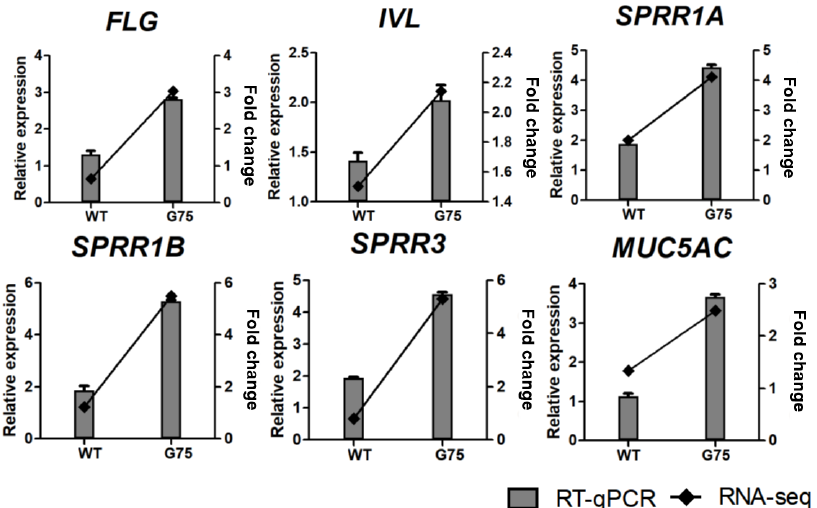
Figure 7. Real-time quantitative PCR validation of RNA-seq data for genes involved in epithelium development and differentiation from HT-29 stimulated by CotG-p75. The right and left y-axis represent the fold change of RNA-seq data and relative expression of RT-qPCR data, respectively. The relative mRNA expression was compared with spore-untreated control. RT-qPCR analysis for mRNA expression of selected genes was normalized against GAPDH . RT-qPCR data are presented as mean ± standard deviation ( n =